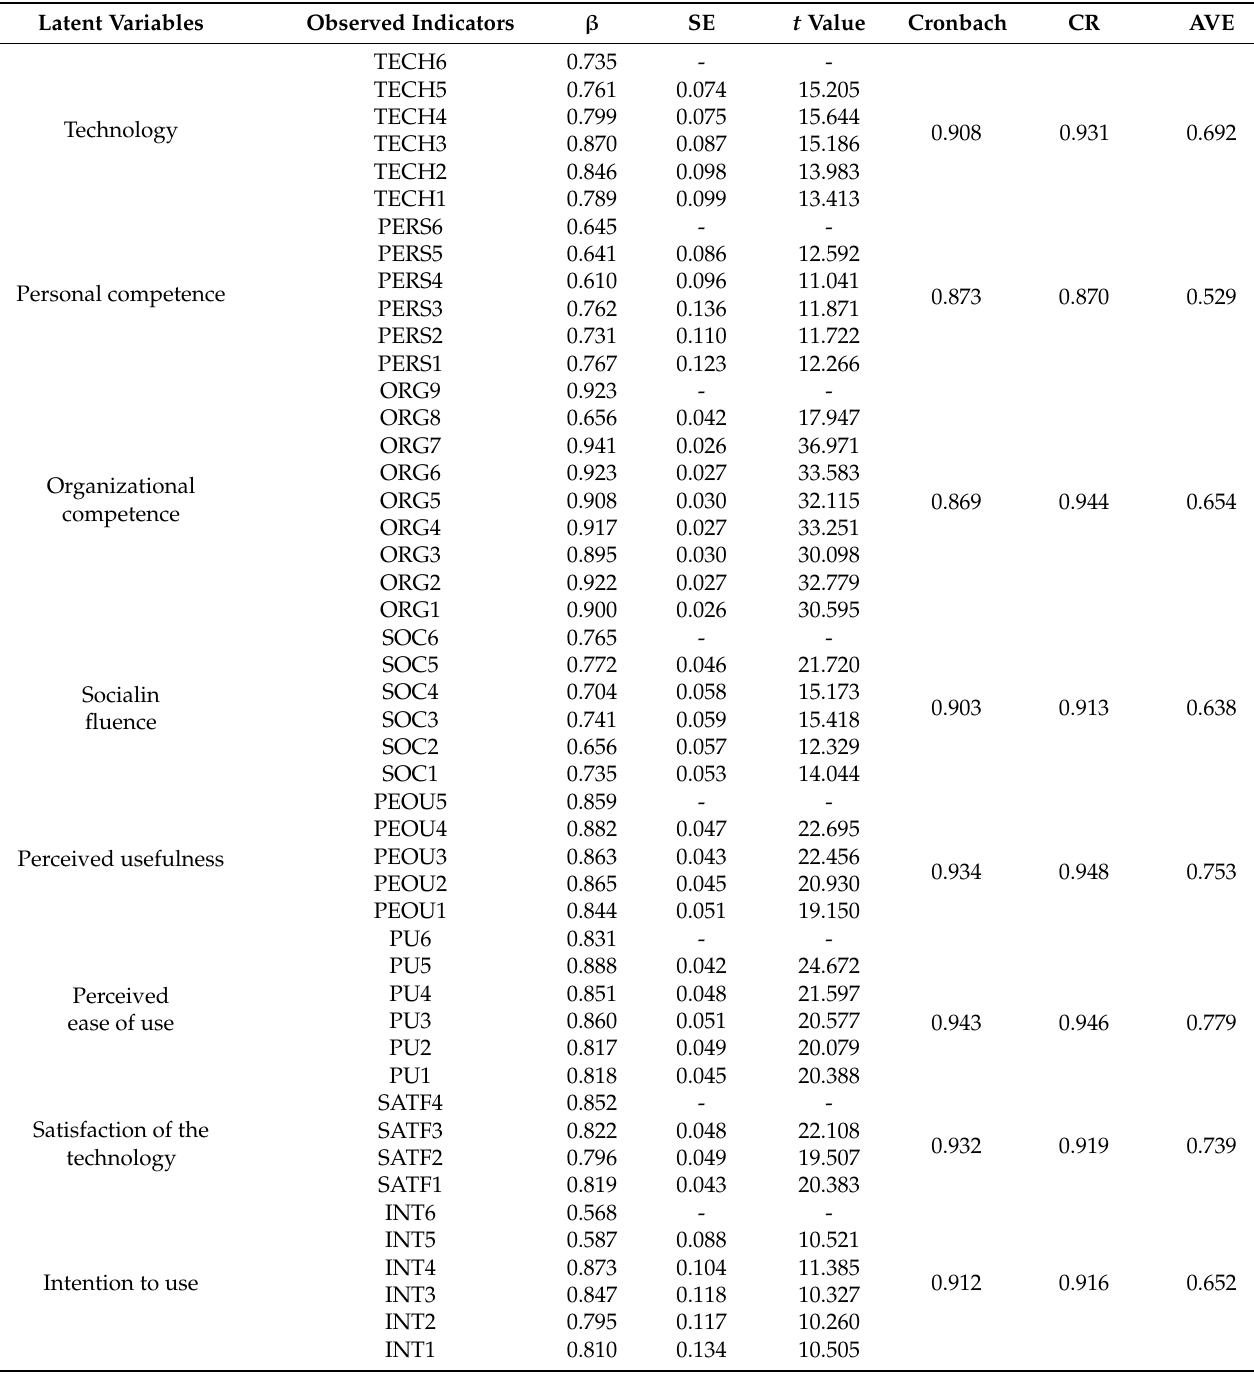
Table 5. CFA results for measurement